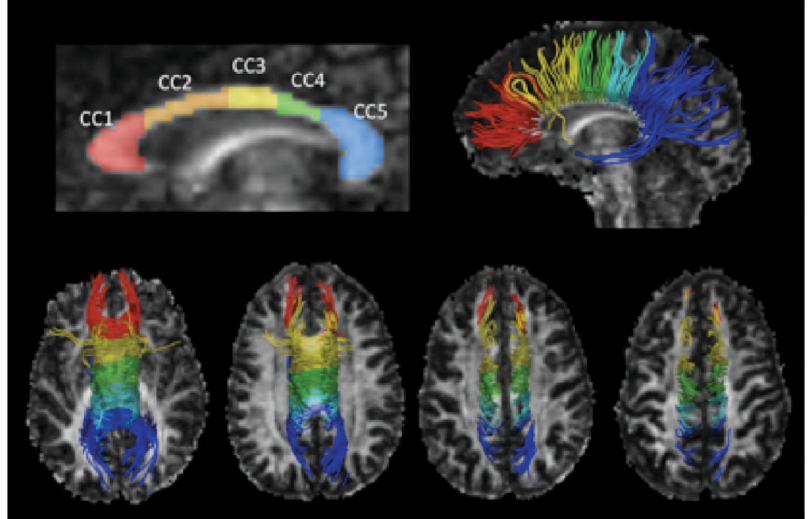
Figure 1 - Corpus callosum segmentation and tractography. The FA map and the CC segmentation model of one healthy subject are illustrated in the top-left of the figure. The top-right image shows the sagittal 3D view of WM tracts derived from the segmented CC projected onto the FA map. The four bottom images show the superior view of the fibers projected in ascending axial slices. CC1: rostrum and genu, connects with the prefrontal and orbitofrontal cortices; CC2: anterior midbody, connects with the premotor and supplementary motor areas; CC3: posterior midbody, connects with the primary motor areas; CC4: isthmus, connects with the primary sensory area; CC5: splenium, connects with the parietal and temporal lobes and the visual cortex.